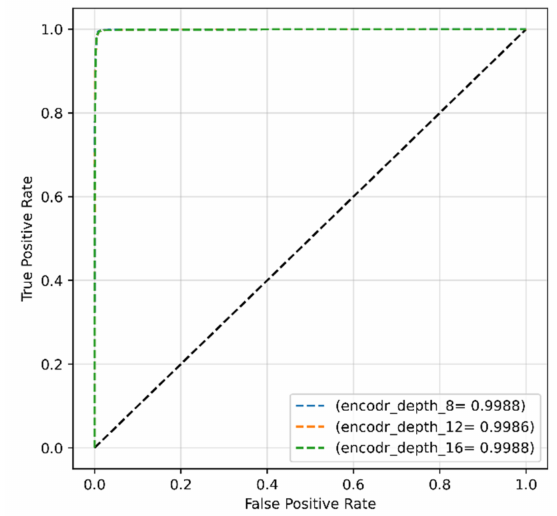
Figure 18. ROC curves of the proposed model obtained with modified dataset and encoder’s depth of 8, 12, and 16.